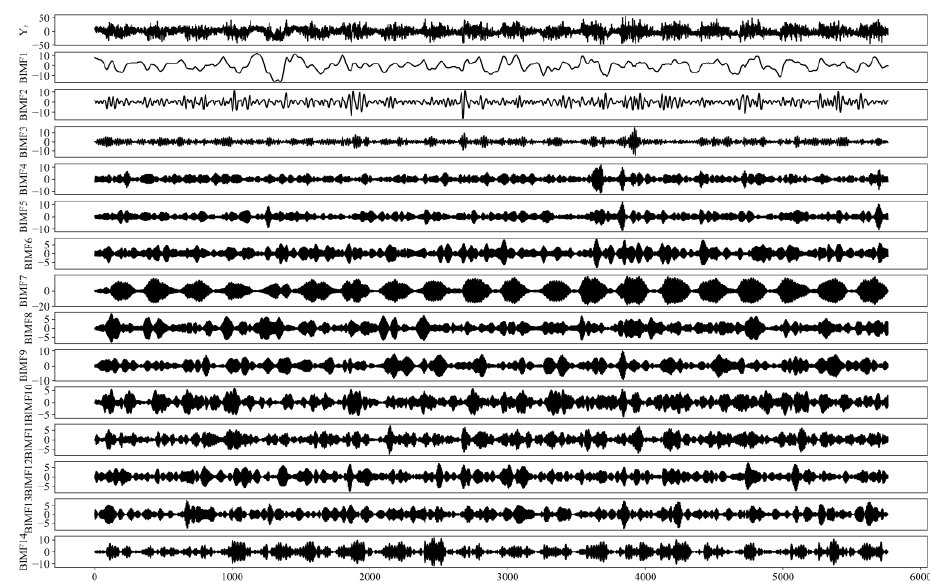
Figure 7. GA optimization of VMD residual term decomposition results.